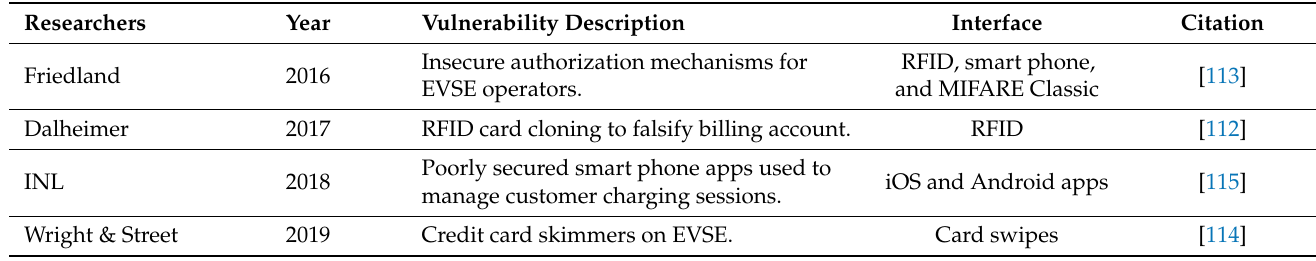
Table 2. EV operator interface